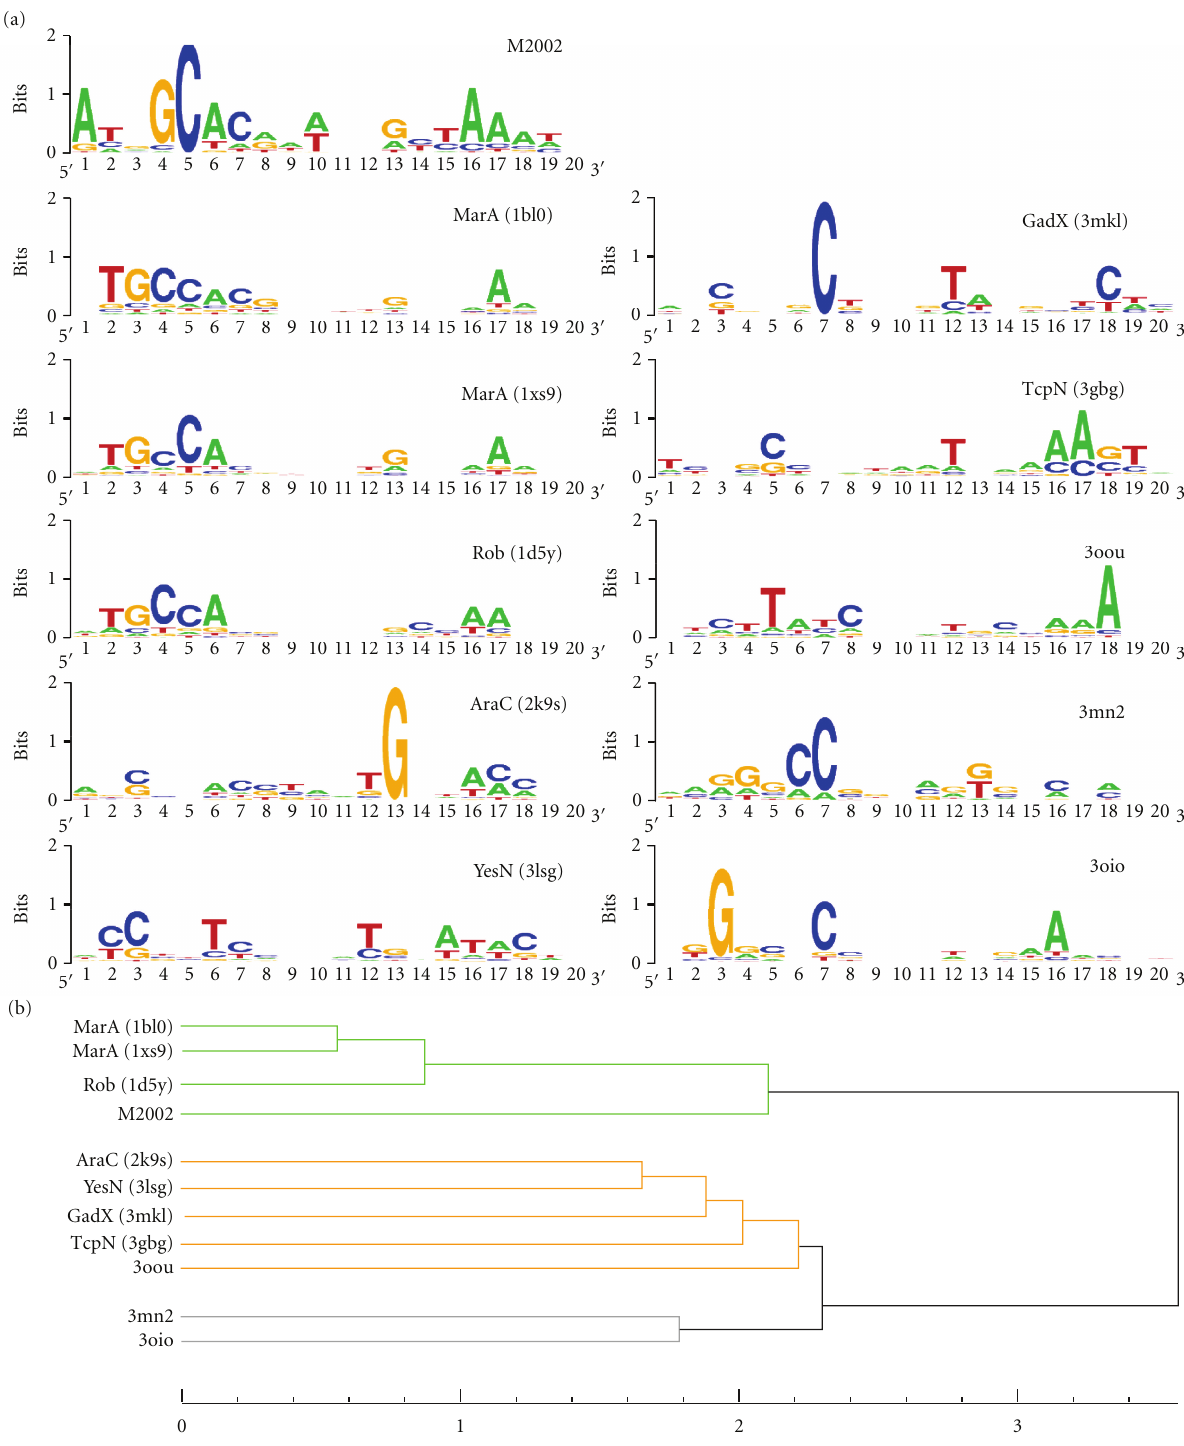
Figure 5: Sequence logos of predicted DNA binding sites and hierarchical clustering of the corresponding PWMs. (a) Sequence logos generated from an ensemble of top-scored random DNA sequences of protein-DNA complexes modeled after MarA (PDB code: 1bl0). M2002 denotes a set of 24 known binding sequences of the marA/rob/soxS regulon reported by Martin and Rosner in 2002 [32]. (b) Hierarchical clustering generated by calculating the Euclidean distance of the PWMs and applying the minimum variance clustering method (Ward’s method). Three clusters are